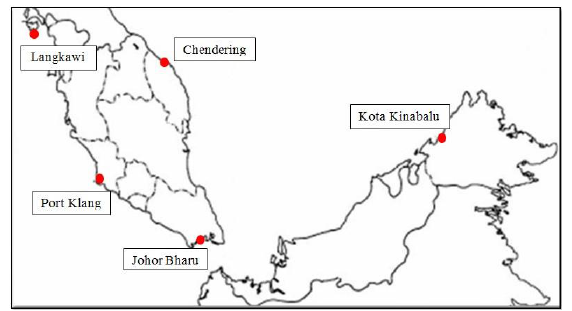
Figure 1. Tidal station that has been chosen in this research In planning stage, the suitable tidal software has been chosen in this study to process the tidal data for tidal station. Tidal